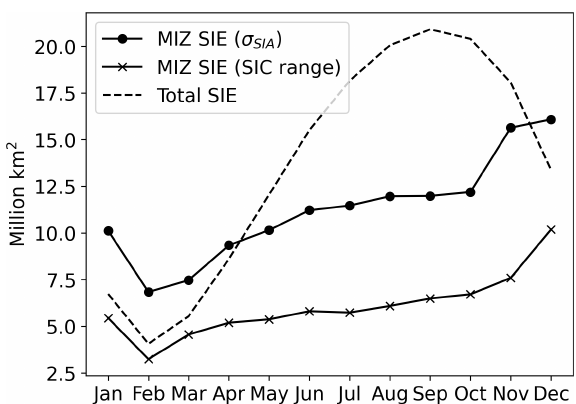
Figure 11. Estimated climatological extent of the MIZ and total sea ice extent computed from the monthly climatologies of the NOAA/NSIDC CDR. The filled-circle line is obtained from the σ n indicator using the threshold 0.1, which also includes the SIA coastal